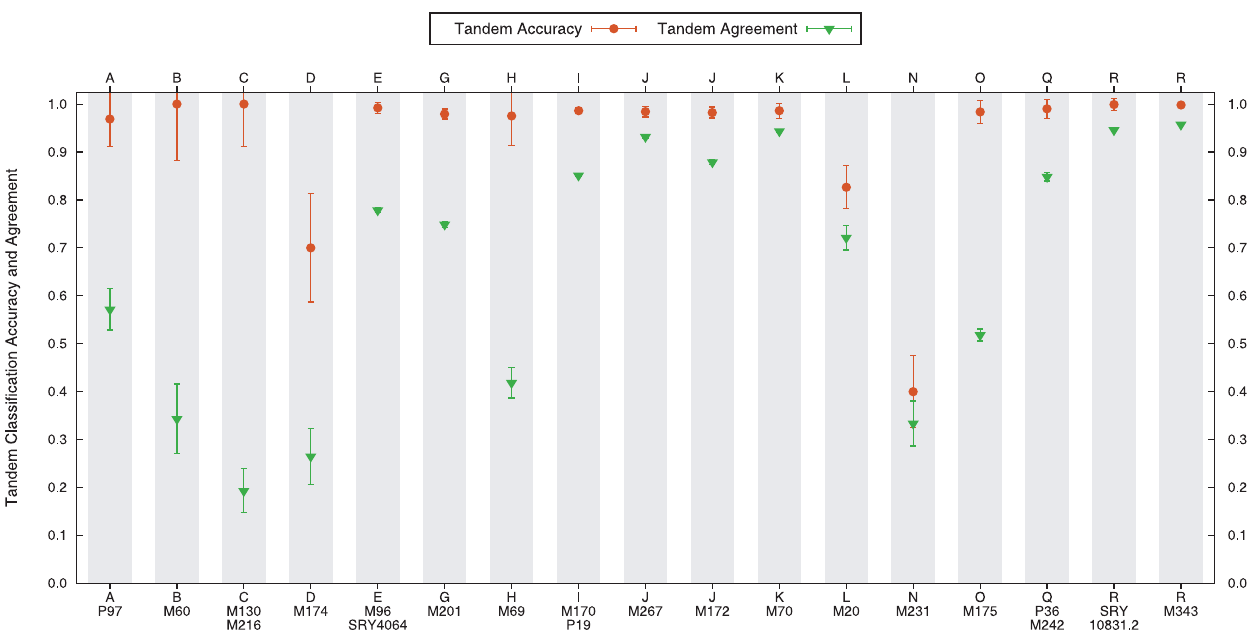
Figure 3. Average accuracy of the tandem approach for cross-validation on the ground-truth training set. The average proportion of samples with agreement for all four classification methods is also shown. The haplogroups with the highest rate of tandem disagreement have a low representation in the training data.